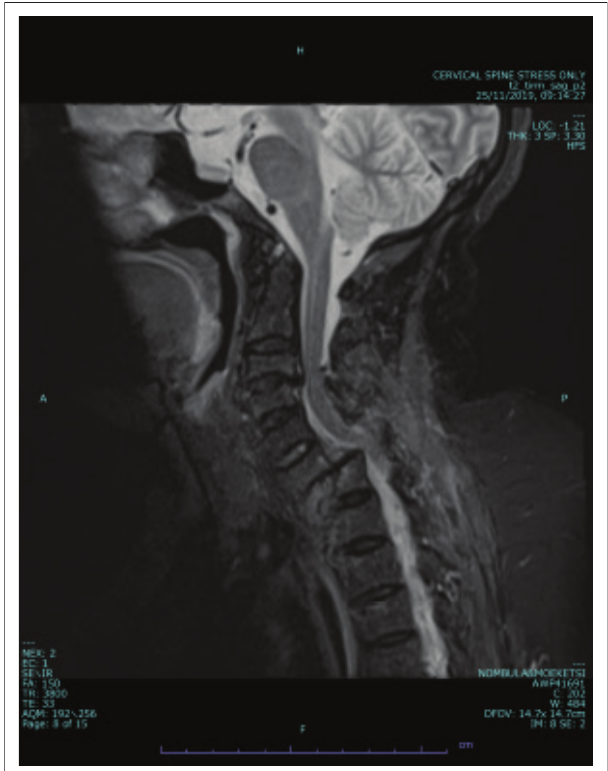
FIGURE 2 : Cervical sagittal T2 weighted